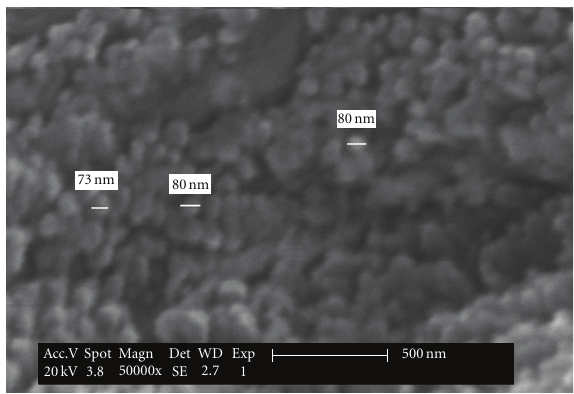
Figure 1: SEM image of nanocomposite (specimen no. 10, × 50000).